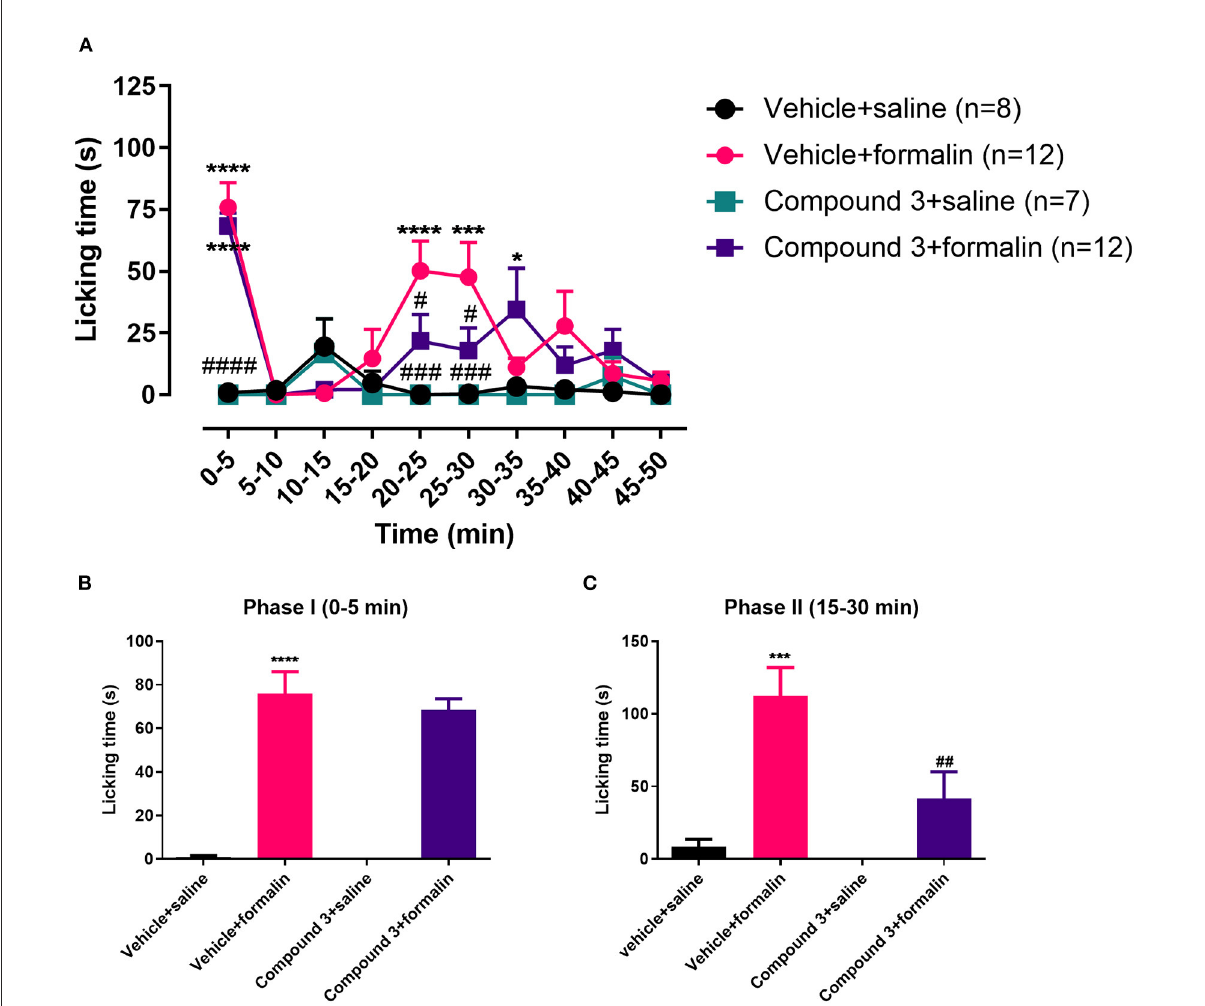
FIGURE2 Time course (A) and cumulative licking time (B,C) induced by formalin injected in the hindpaw, after pre-treatment with a double dose of vehicle or cpd3 (11 mg/kg). (A) Two-way ANOVA followed by Bonferroni post hoc test. (B,C) One-way ANOVA followed by Bonferroni post hoc